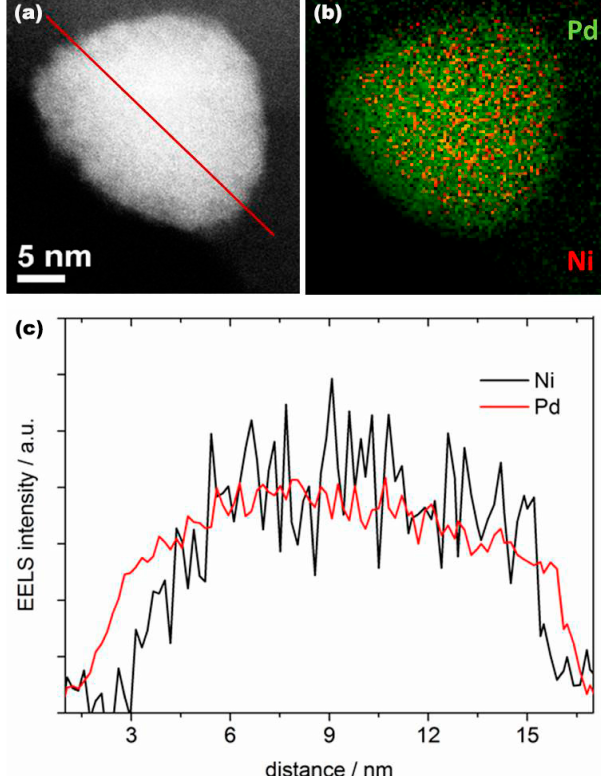
Figure 1. ( a ) HAADF-STEM image of PdNiN core-shell nanoparticle; ( b ) Two dimensional EELS mapping of Ni L signal (red) and Pd M signal (green) from a single nanoparticle; ( c ) EELS line scan profile for Pd M-edge and Ni L-edge along the scanned line indicated in ( a